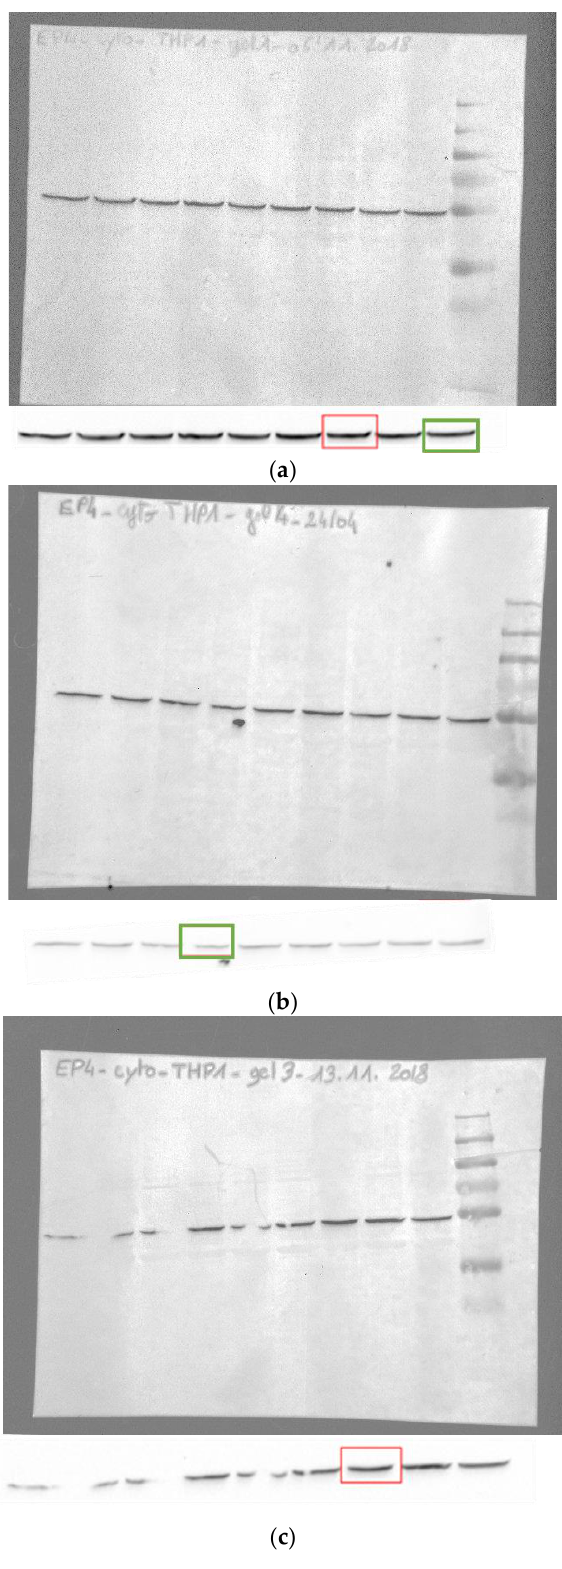
Figure A4. Gels blots for EP4 ( a ) EP4 in THP-1 incubated with LPS (1 µg/mL) ( b , c ) EP4 in THP-1, without LPS. Red squares: Control, Green squares: with LS-E (50 µg/mL).